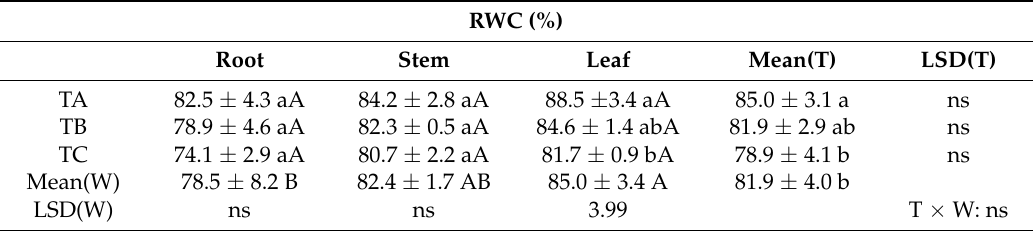
Table 1. Effect of three watering treatments (TA, well-watered (85% pot capacity (PC); TB, moderate water stress (65% PC); and TC, severe water stress (45% PC)) on the RWC of leaves, stems and roots. The values are means ± one standard error of the mean ( n = 3). Differences were tested with Tukey’s method.